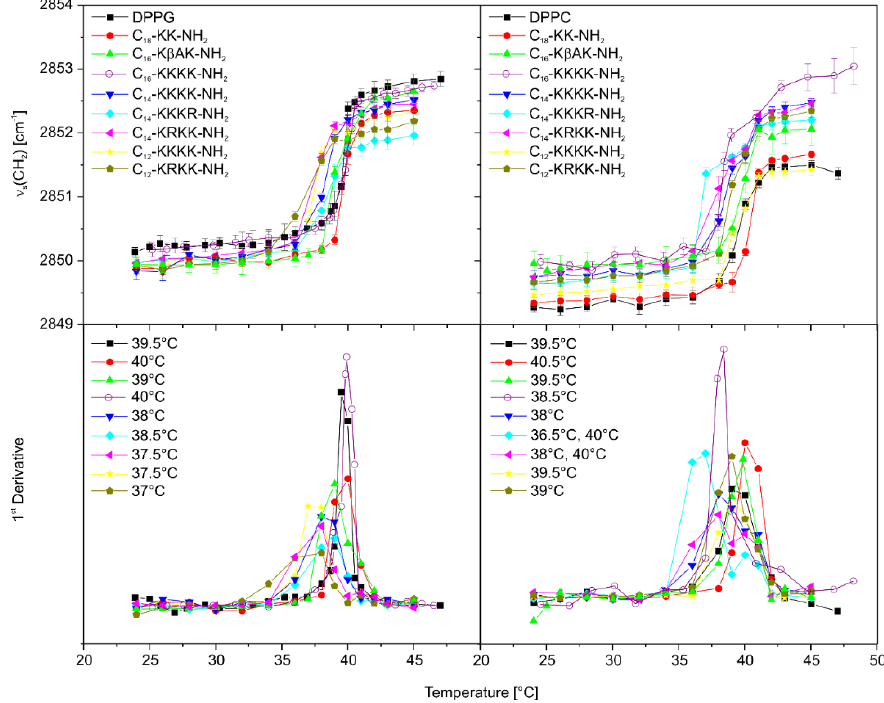
Figure 5. Changes in the ν s (CH 2 ) stretching vibrations vs. temperature before and after addition of the lipopeptides in a 10-fold deficiency to DPPG (left) and DPPC (right).